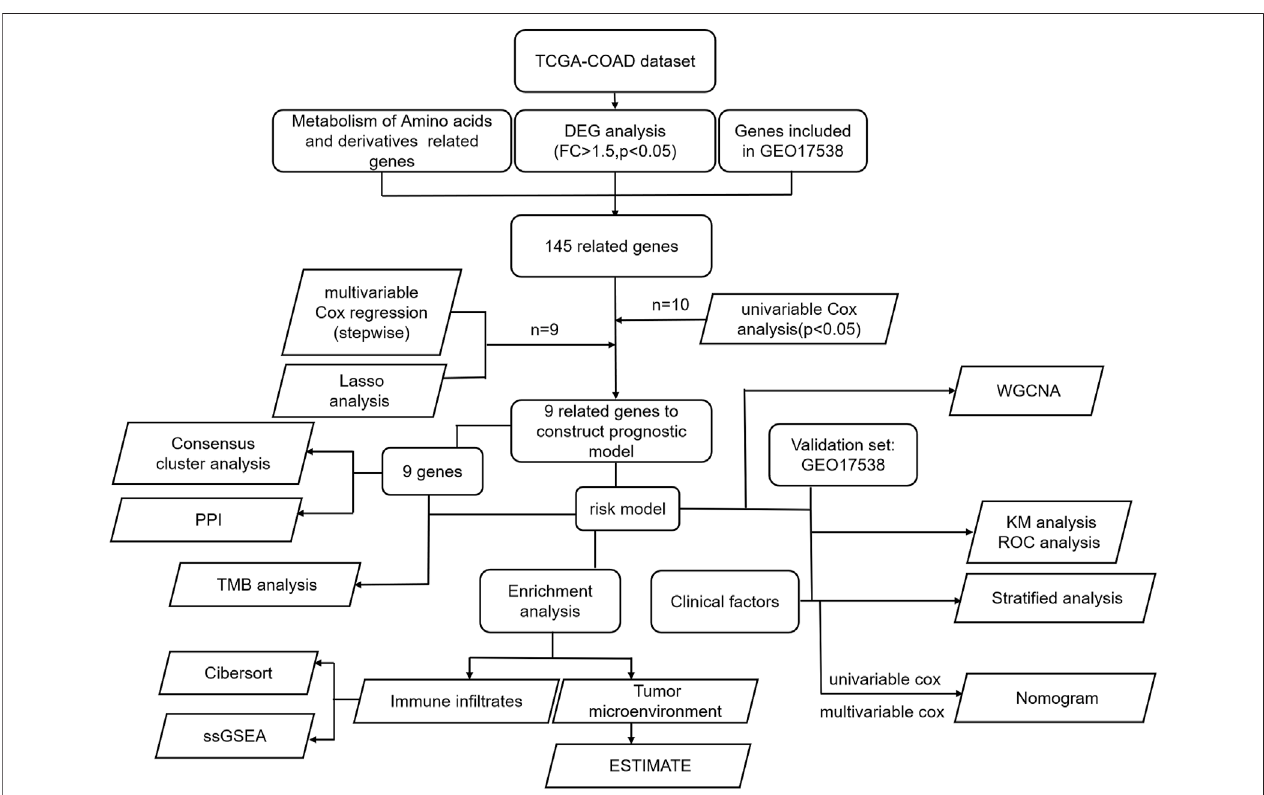
FIGURE 1 | All the procedures of this